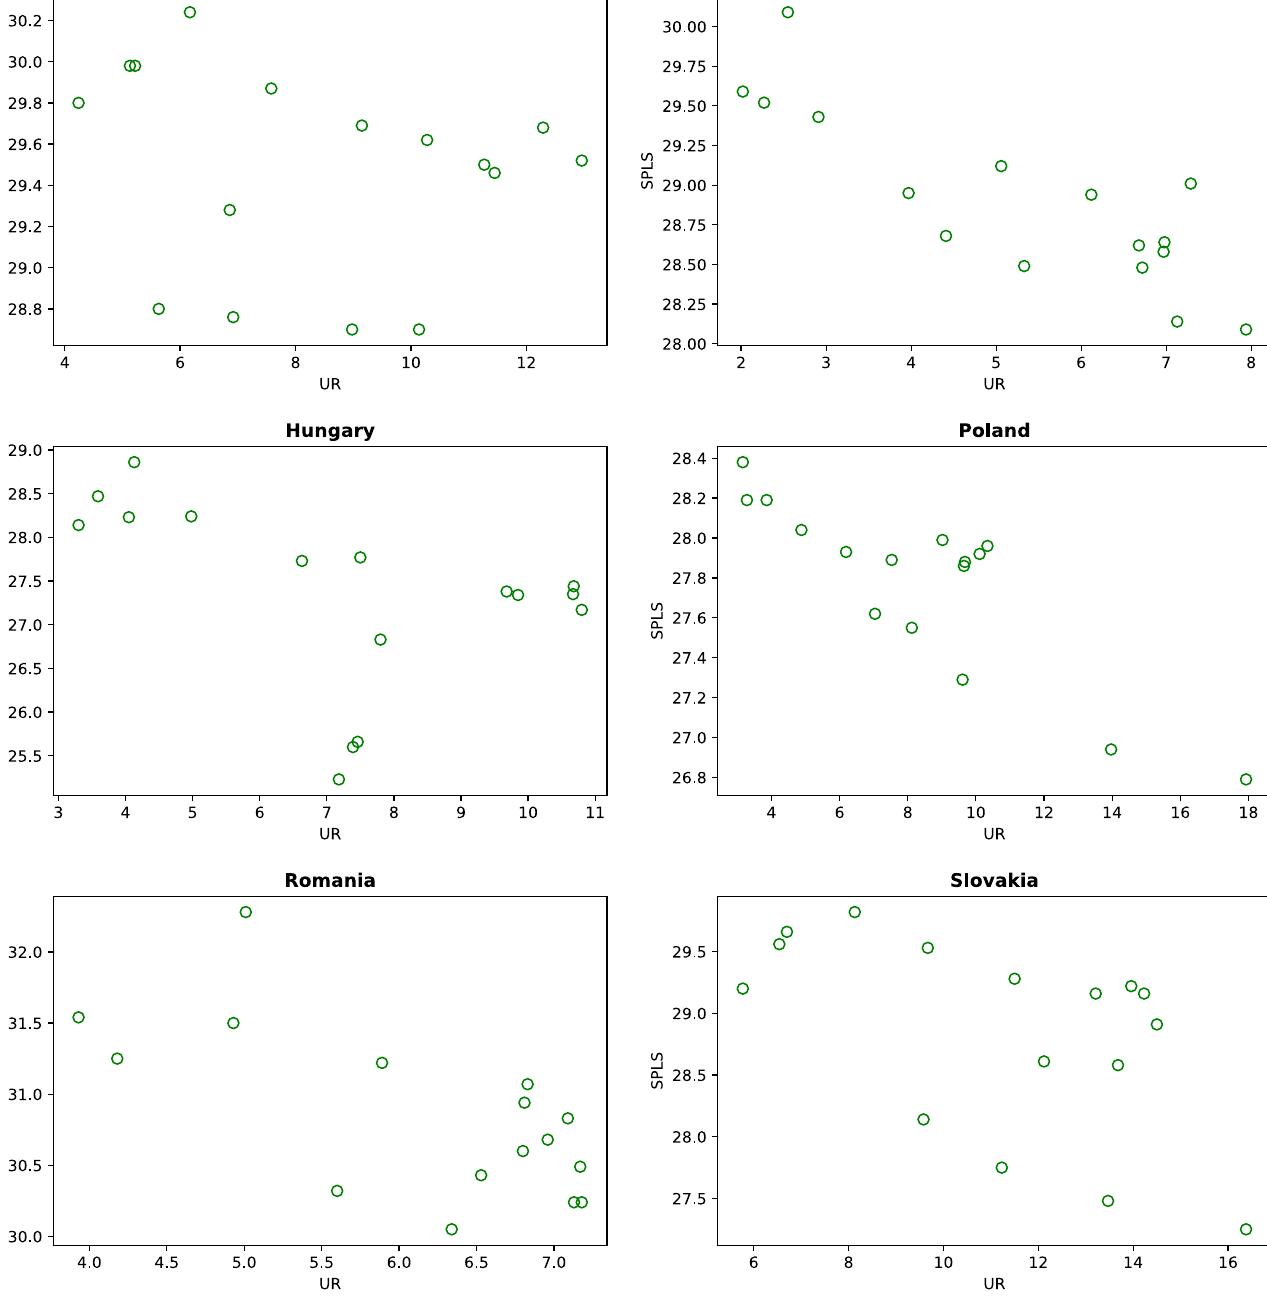
Figure 10. Scatter plot of SPLS (percentage) on unemployment rate